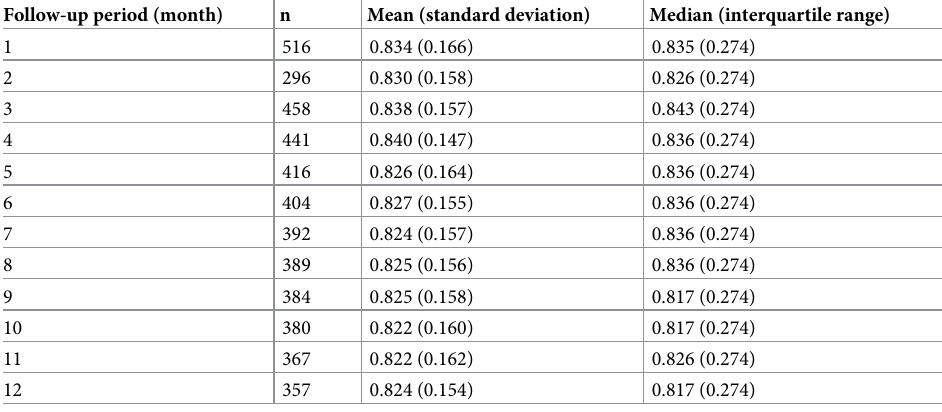
Table 6. Mean and median utility values stratified by study follow up